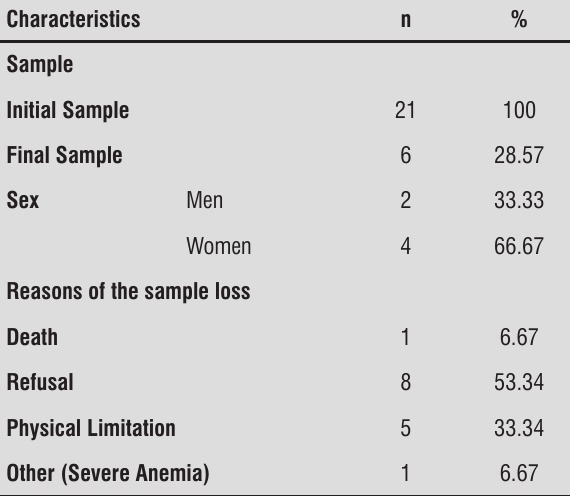
Table 1 - General Characteristics of the Sample Studied Characteristics n Sample